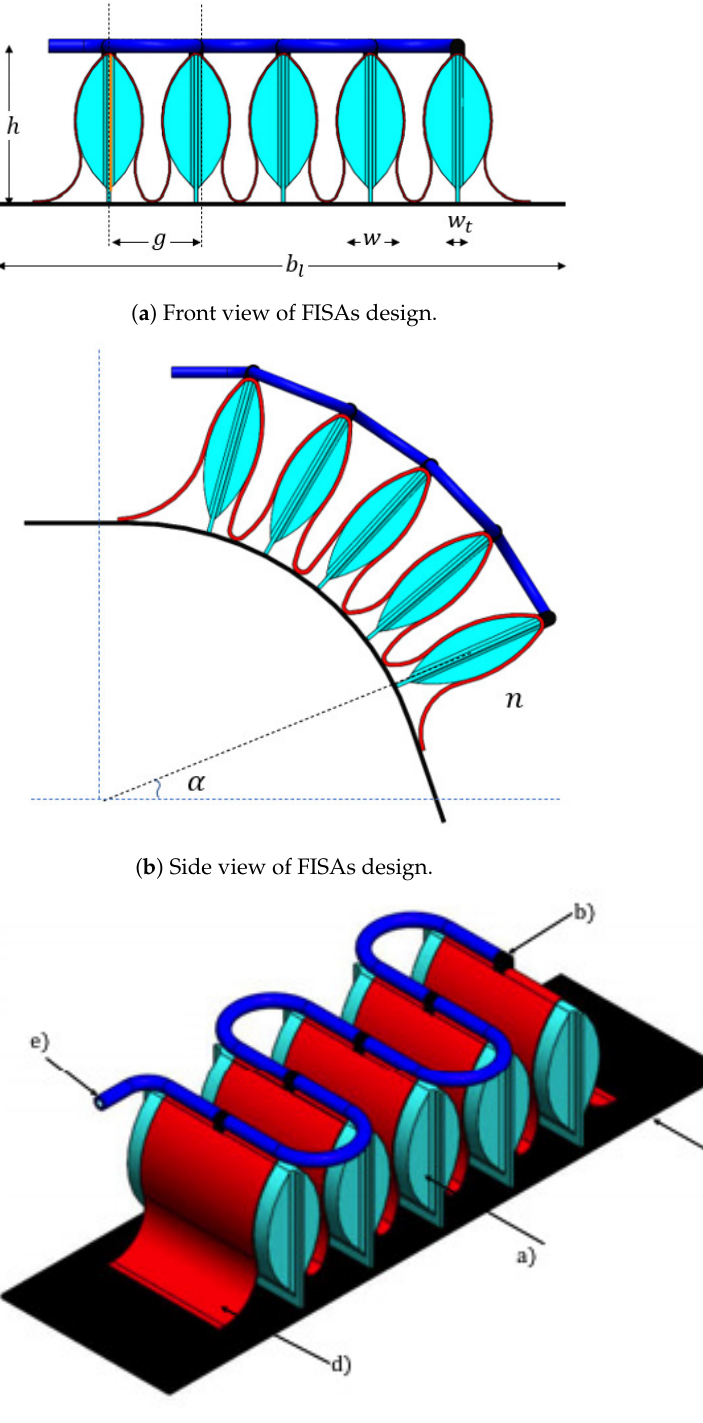
Figure 1. FISAs geometrical parameters on a front view: ( a ) shows the base length bl , wall thickness wt , gap g , height of air channel h and width of chambers w . ( b ) shows the angle of attack between the air inlet and base length, α , and the number of chambers n in a semicircular path. ( c ) FISAs assembly a: air chambers, b: T connectors, c: inelastic fabric layer, d: fabric chambers containers and e: air